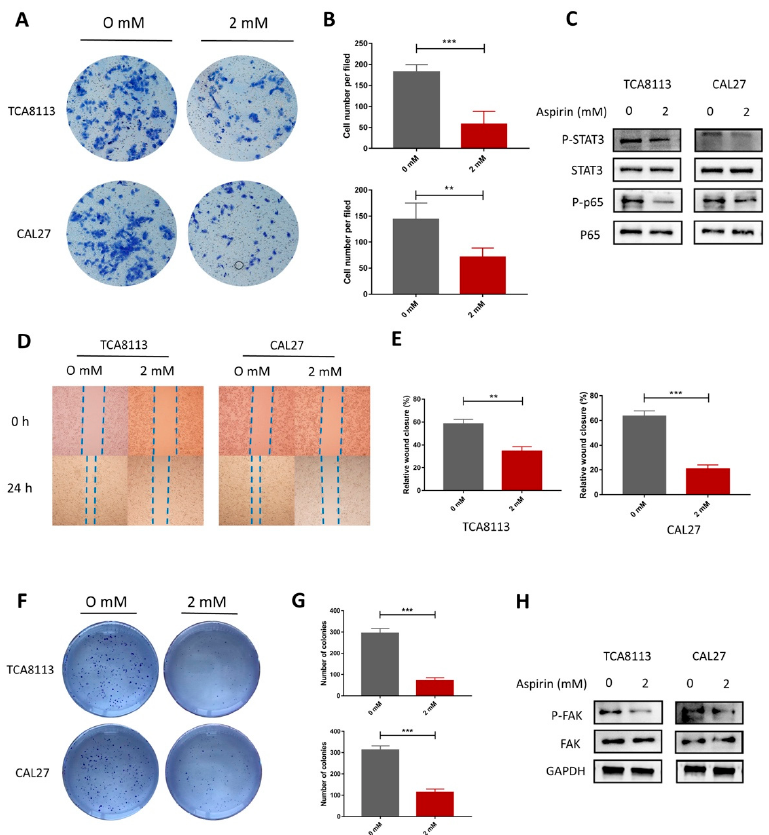
Figure 5. Aspirin decreased the migration and invasion in the TCA8113 and CAL27 cells. ( A , B ) The representative pictures of the Transwell invasion assay in the TCA8113 and CAL27 cells with ASA treatment. ( C ) The ASA treatment decreased the phosphorylation of Stat3 and p65. ( D , E ) The ASA treatment exhibited a slower scratch closure rate by the wound-healing detection in TCA8113 and CAL27 cells. ( F , G ) The colony formation was inhibited by ASA. The TCA8113 and CAL27 cells were incubated with aspirin for 14 days and the cell colonies were stained with crystal violet. The cell colonies with a diameter larger than 50 μ m were counted using ImageJ software. ( H ) The phosphorylation of FAK were inhibited after they were ASA treated. Protein levels were detected by Western blotting using indicated antibodies, and GAPDH was used as a loading control. ** p < 0.01 and *** p < 0.005. The data were presented as the mean ± SD ( n = 3).